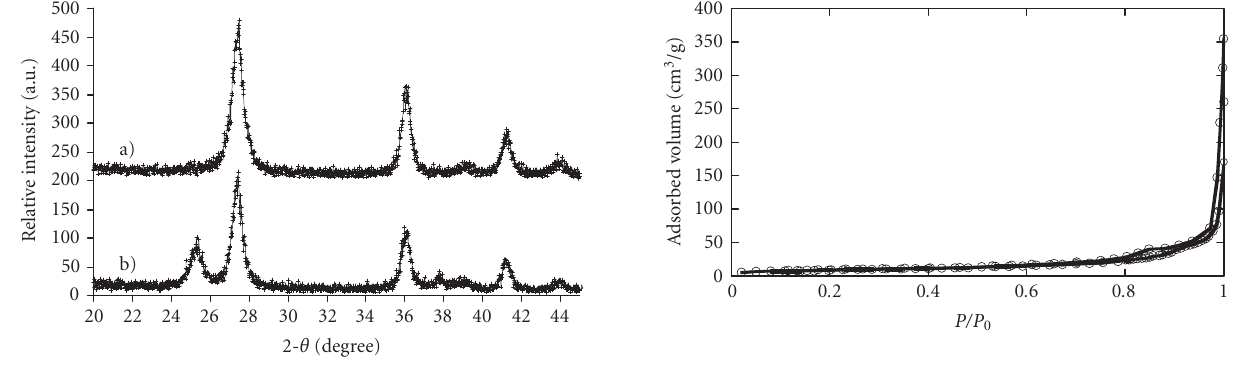
Figure 1: Wide angle XRD patterns of TiO 2 after calcination at 653 K: (a) pure rutile (sample R100), (b) mixed-phase TiO 2 con- taining 30% anatase and 70% rutile (sample R70).